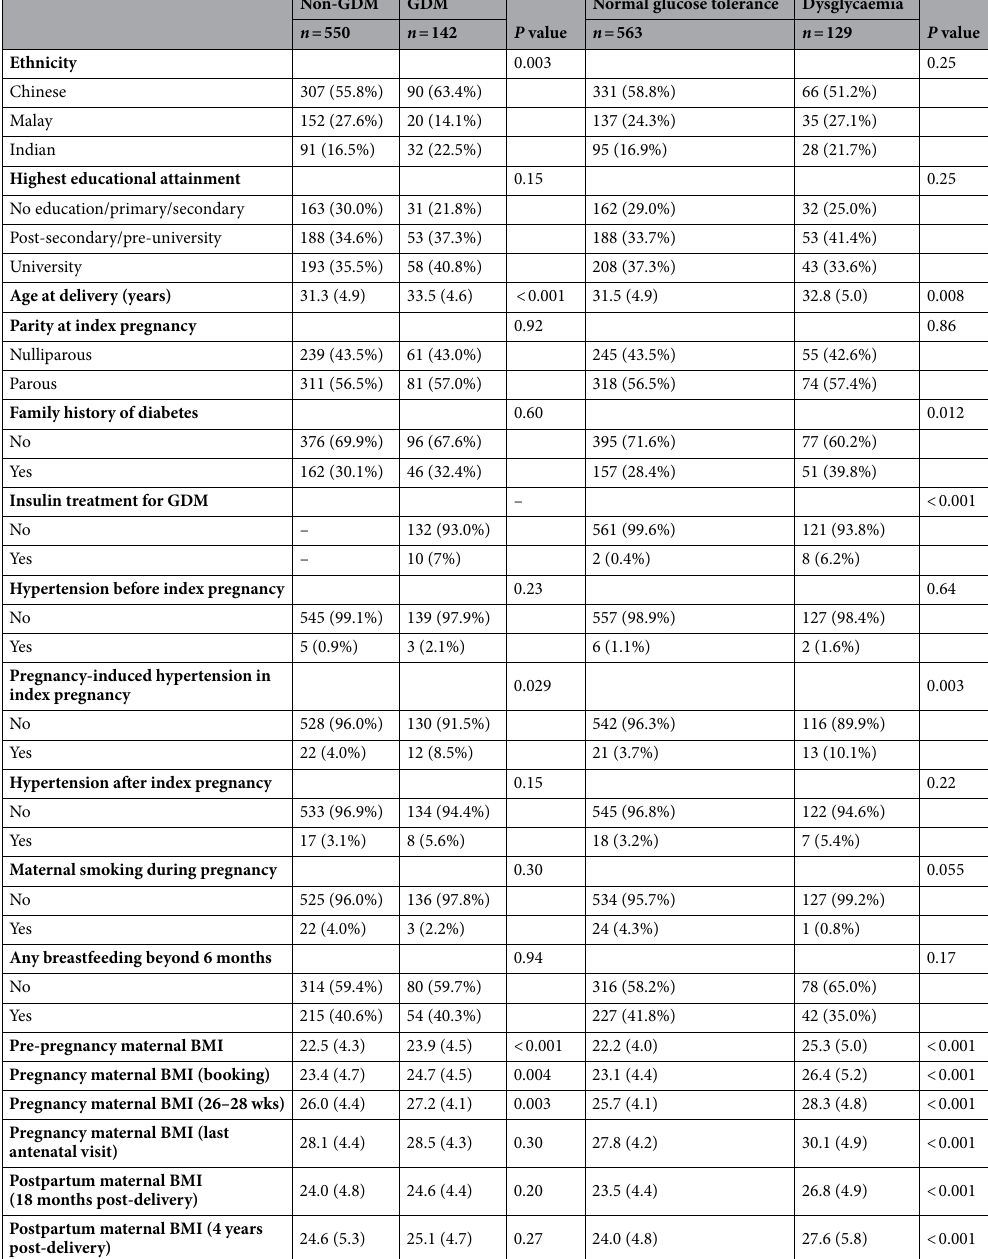
Table 1. Characteristics of participants according to GDM and post-delivery dysglycaemia status. GDM gestational diabetes mellitus, BMI body mass index, wks weeks’ gestation. Data are presented as n (%) for categorical variables or mean (SD) for continuous